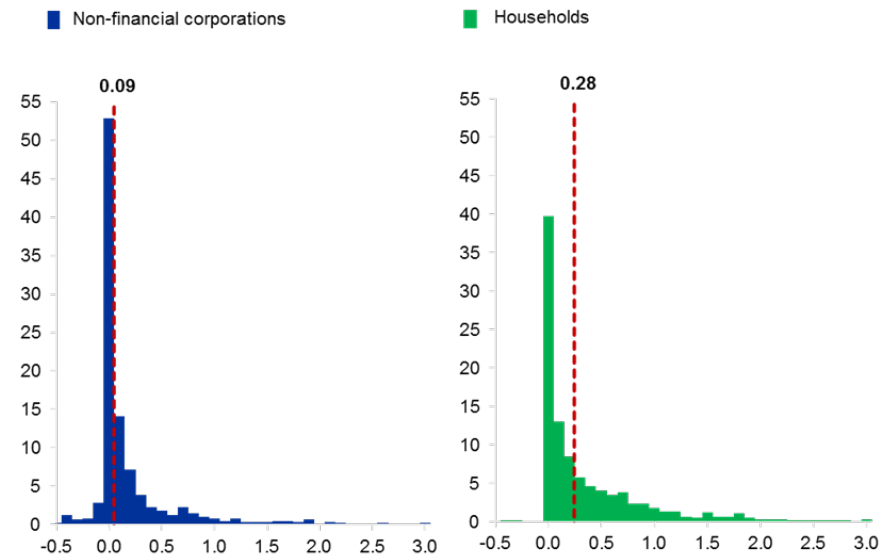
Figure 8. Distribution of deposit rates for non-financial corporations and households across euro area banks (x-axis: deposit rates in percentages per annum; y-axis: frequencies in percentages). Source: ECB. Observations refer to October 2016. Note: Deposit rates on new business as reported by individual banks. The dotted lines show the weighted averages of deposit rates.